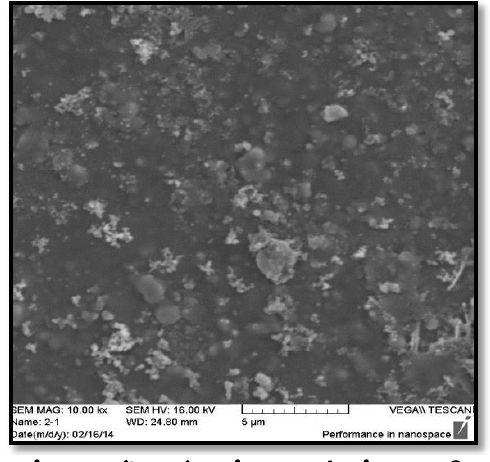
Fig. 7: (SEM) micrograph image for Z :S . 1 0